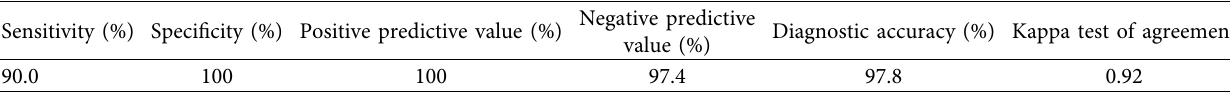
Figure 4: Dermatofibroma. (a) Case diagnosed on imprint smear as benign spindle cell tumor of fibrous origin showing clusters and singly scattered spindle-shaped cells. Background showing foamy macrophages (arrow) (MGG stain, X100). (b) Scrape smear showing cluster of spindle-shaped cells showing bland nuclear chromatin and cytoplasmic projections (H&E, X400). (c) Paraffin-embedded section showing singly scattered and fascicles of spindle-shaped tumor cells with bland nuclear chromatin (H&E, X200). Table 2: Statistical analyses of results given by the scrape smear